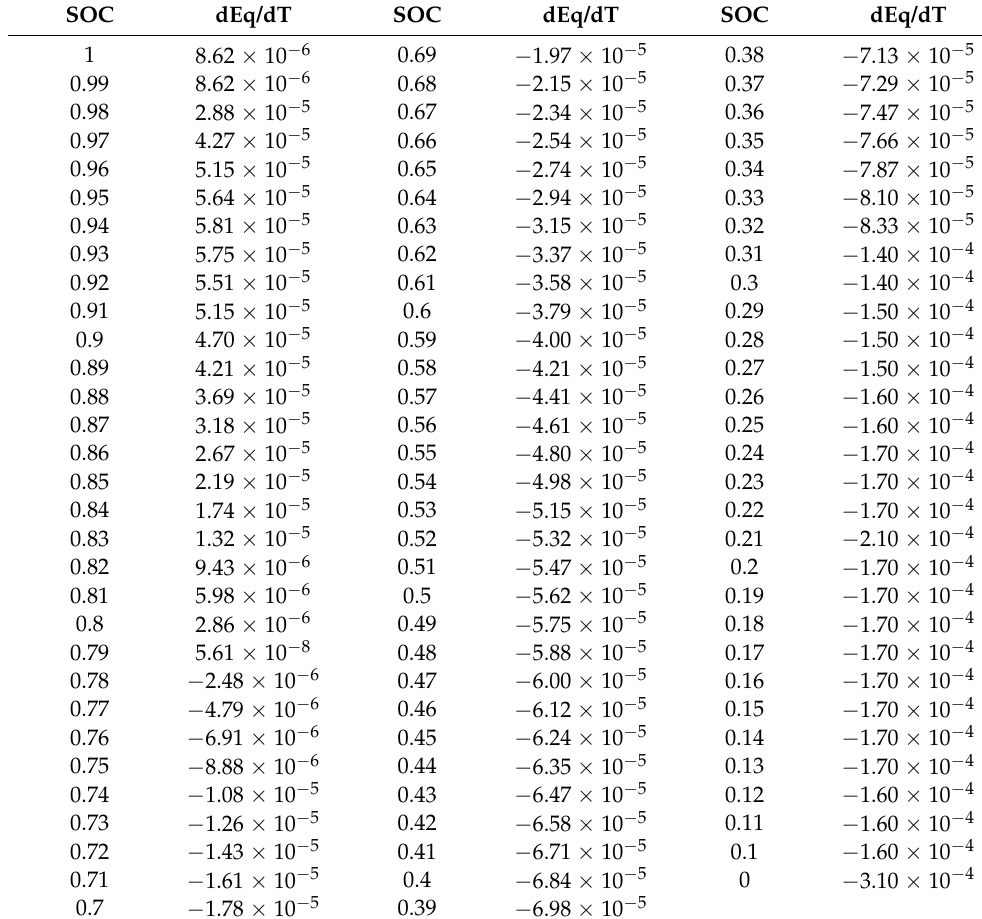
Table 3. Open circuit partial derivative with respect to temperature for the iron phosphate